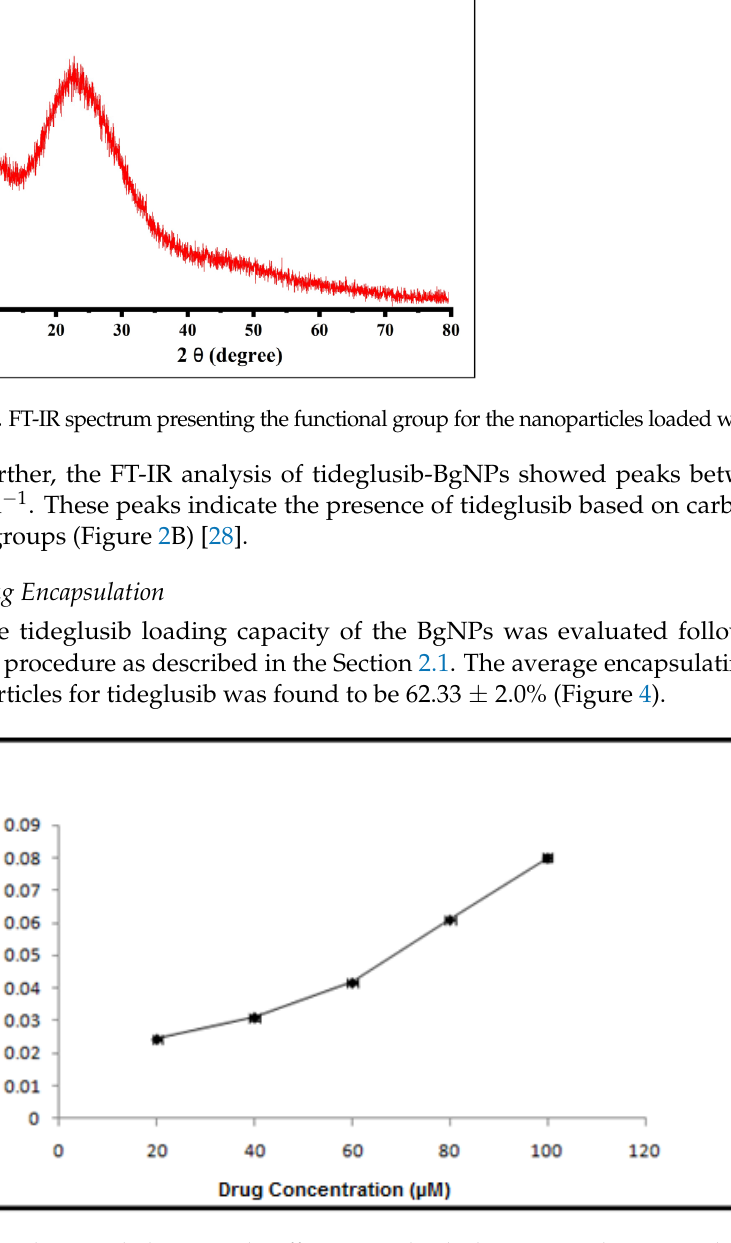
Figure 4. A line graph depicting the efficiency with which nanoparticles encapsulate tideglusib.